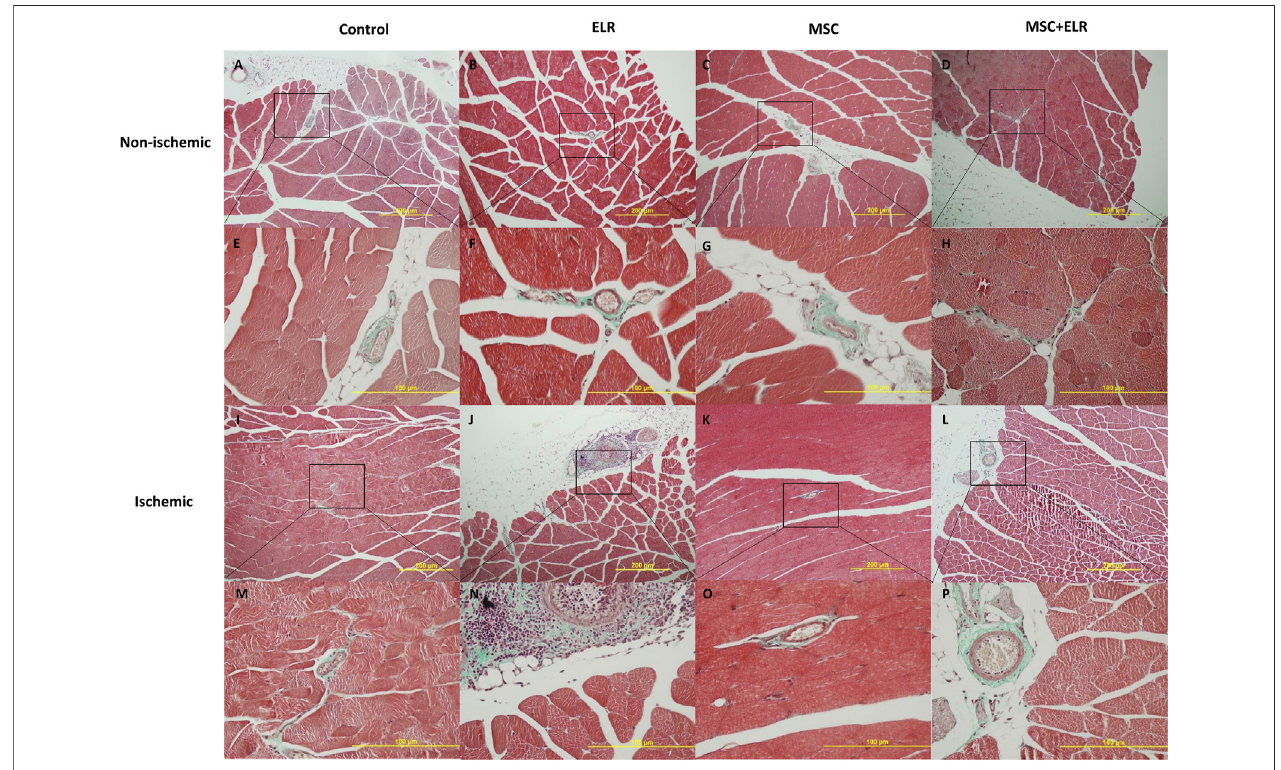
FIGURE 4 | Masson ’ s trichrome staining for the analysis of collagen distribution. Representative images of ischemic and non-ischemic hindlimbs stained with Masson ’ strichrome after 21 days post surgery are represented. (A – D) and (I – L) 10X ampli fi cation. (E – H) and (M – P) 40X ampli fi cation. ELR: elastin-like recombinamer; MSC: mesenchymal stromal